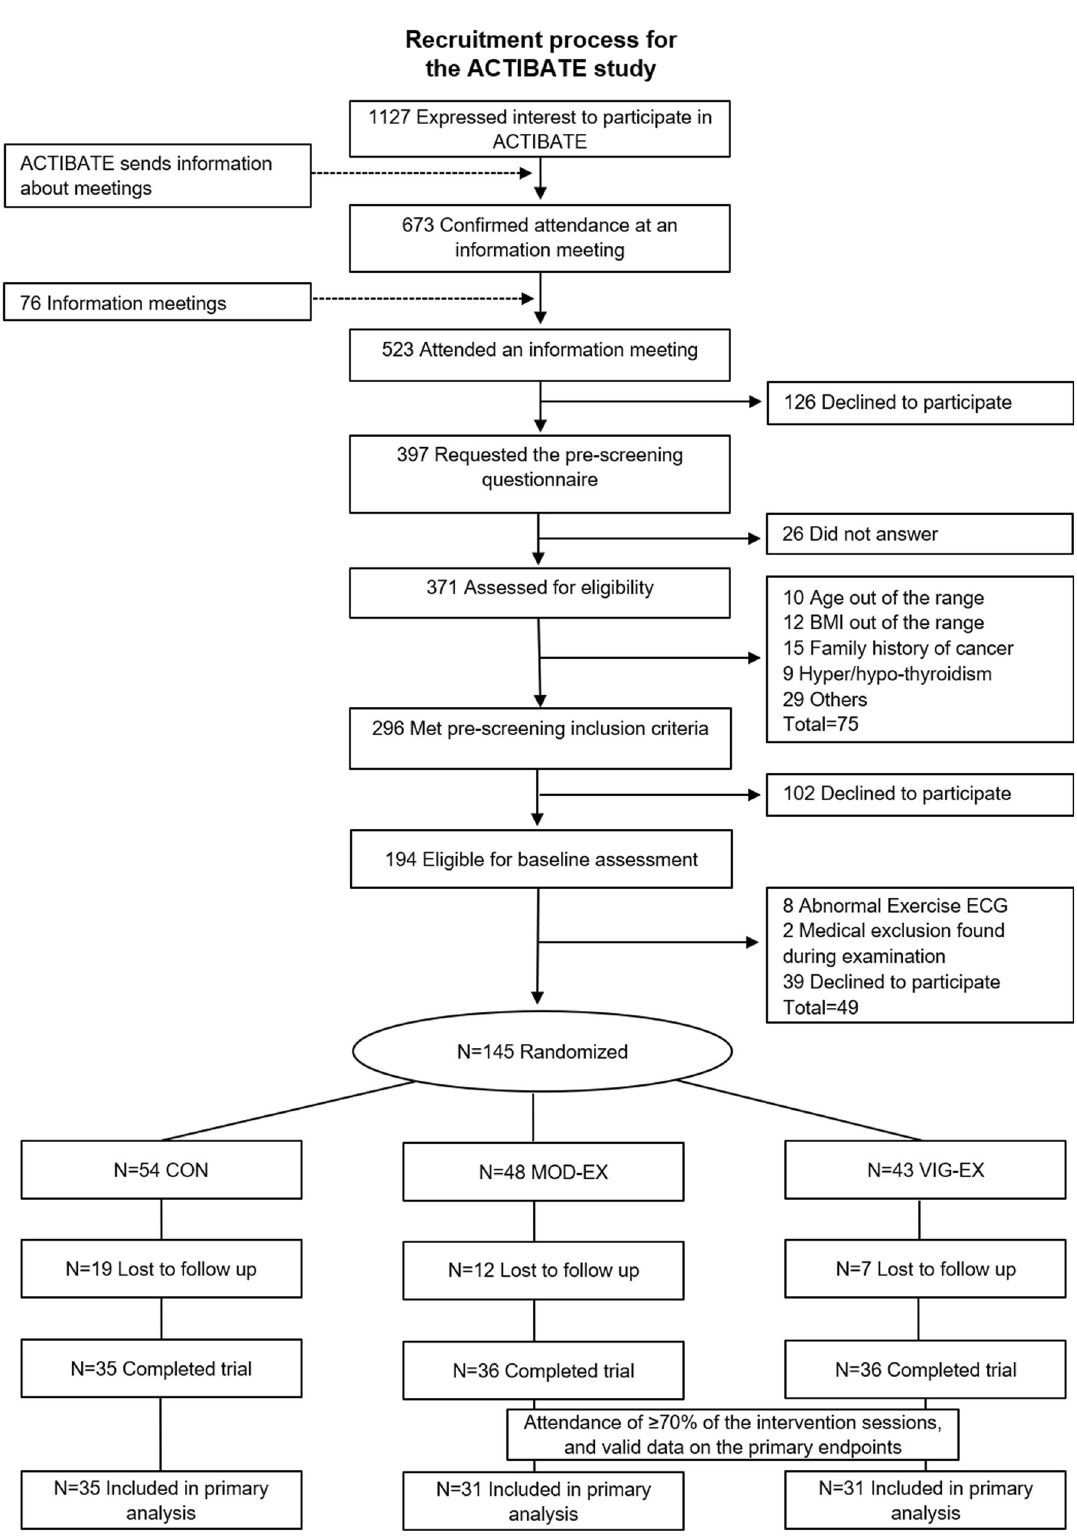
Fig.1|ParticipantenrollmentintheACTIBATEstudy. BMIbodymassindex,CONcontrolgroup,MOD-EXmoderate-intensityexercisegroup,VIG-EXvigorous-intensity exercise group, ECG